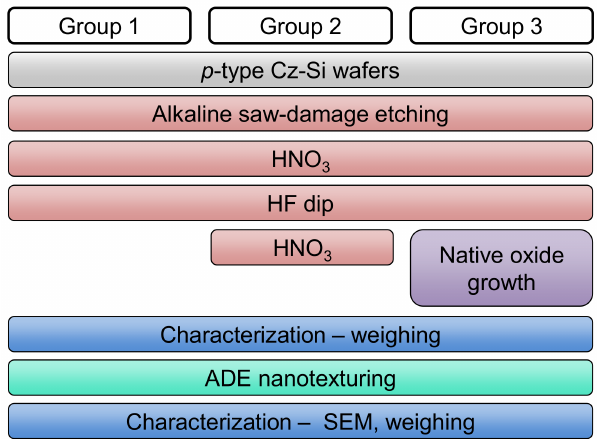
Figure 3. Process plan followed to investigate the Arrhenius